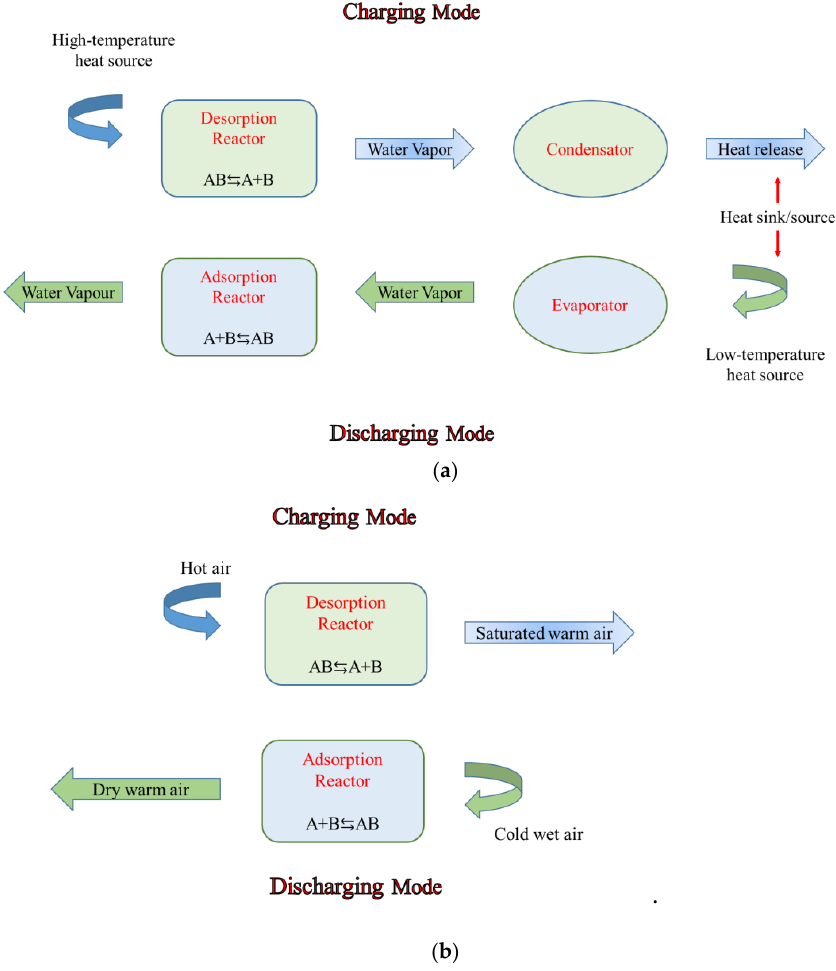
Figure 3. Schematic sketch of ( a ) closed and ( b ) open thermochemical system.